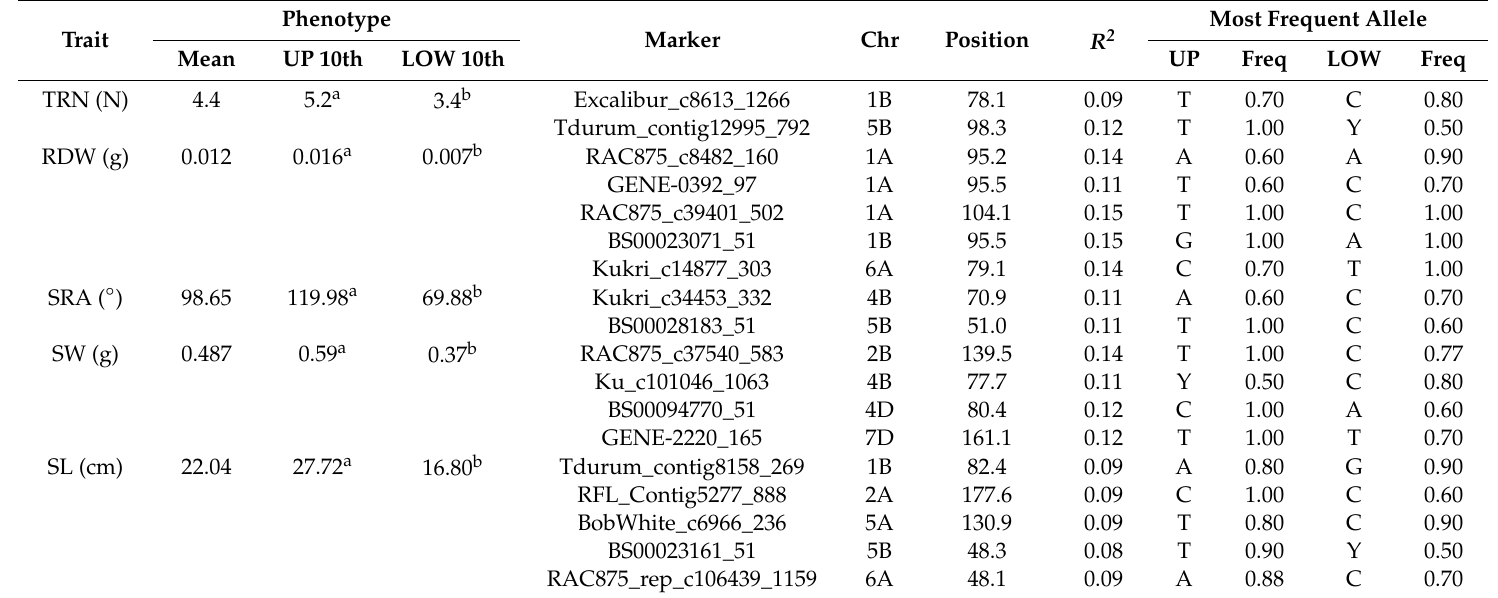
Table 7. Selected significant markers from the GWAS with di ff erent allele composition for the upper (UP) and lower (LOW) 10th percentile of genotypes. Di ff erent letters on the UP and LOW 10th phenotype indicate that means are significantly di ff erent at P < 0.01 following a Tukey